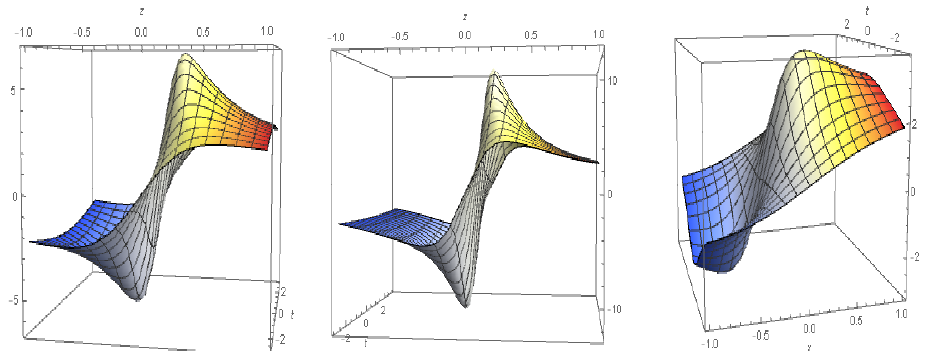
Figure 3. The lump one stripe profiles of the solution ∆ 2 in Equation (10) are interpreted via distinct values of ω = 5, k 1 = 2, ρ = 4, γ = − 1, p = 2, q = − 1, ν = 1, b 0 = 3. Three-dimensional profiles are shown in (i) a 1 = 5, (ii) a 1 = 10 and (iii) a 1 = − 2.